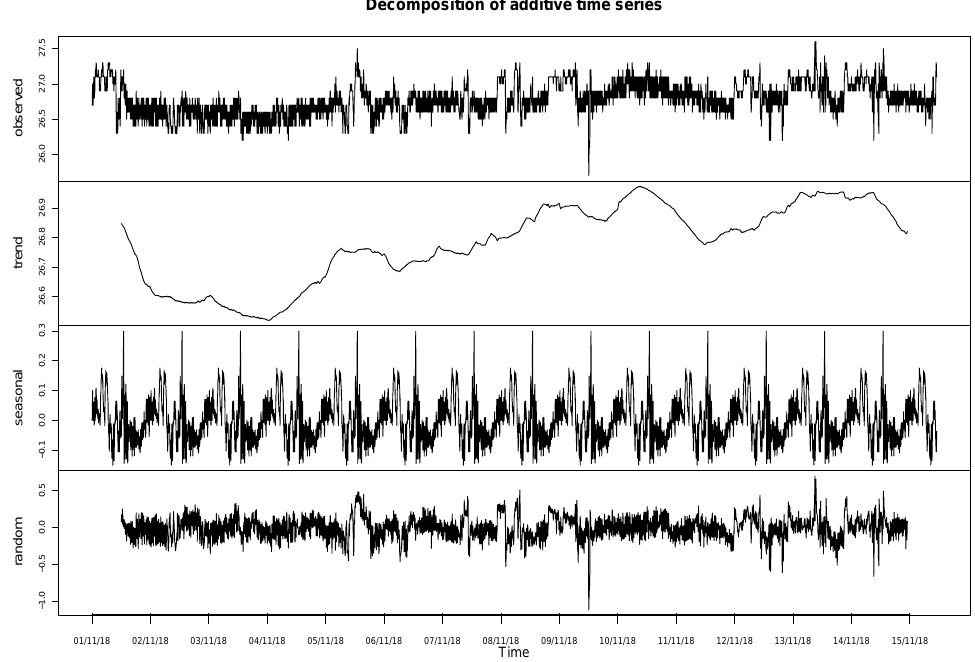
Figure 5. STL decomposition for TAS